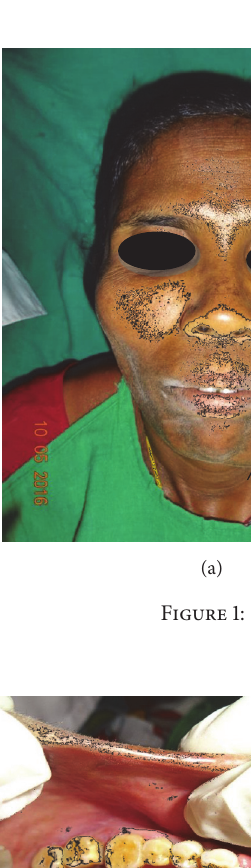
Figure 4: Aspirated